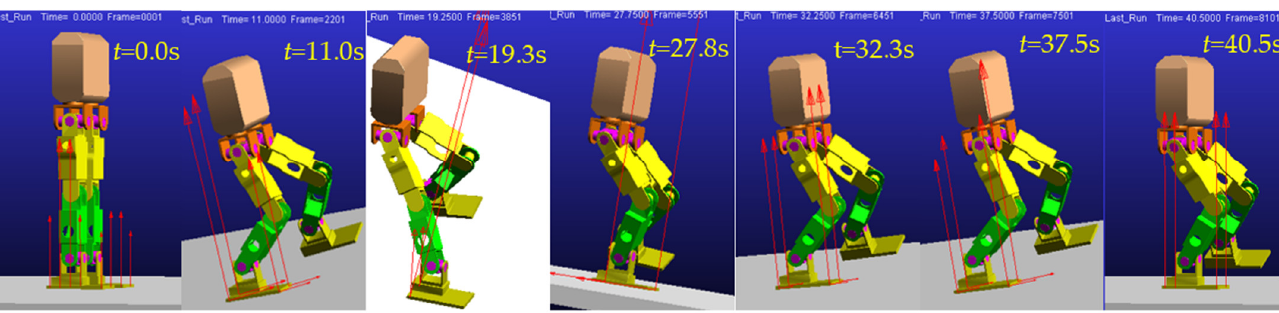
Figure 13. Screenshot of single-stance stability verification simulation with impact.